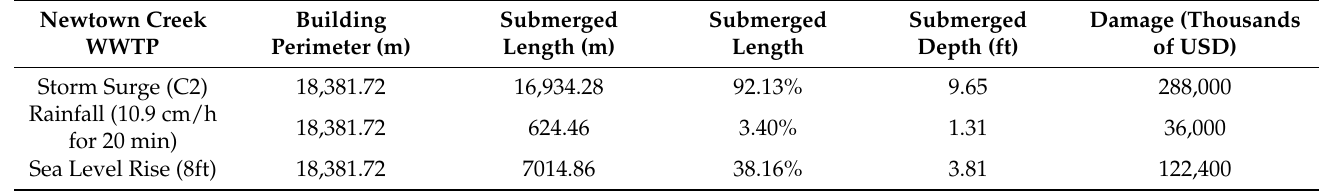
Table 4. Percentage of the submerged length and maximum flood depth for Newtown Creek WWTP and amount of damage in three